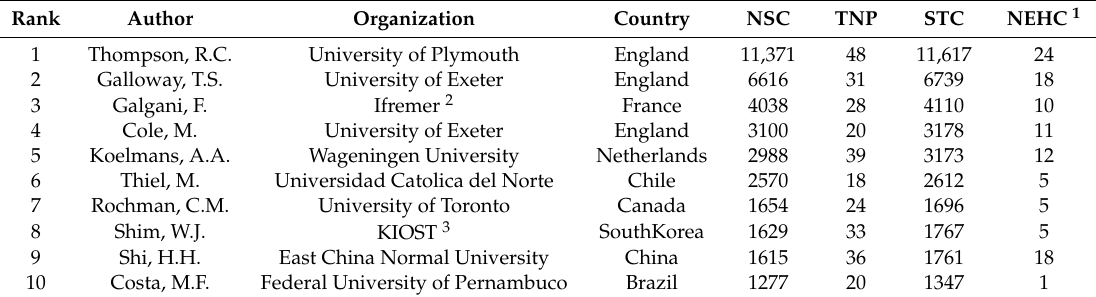
Table 2. The top 10 authors for MPs research ranked by NSC; values for other criteria are given as well.